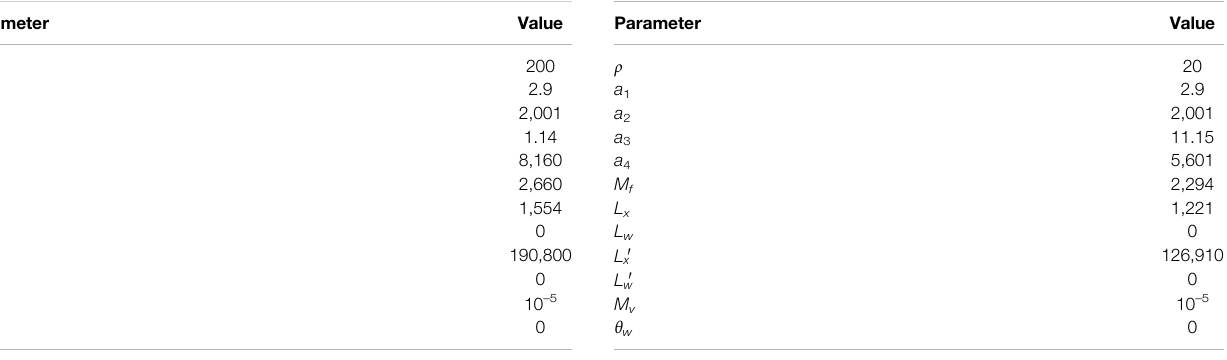
TABLE 5 | Second set of parameters for CSTR model.